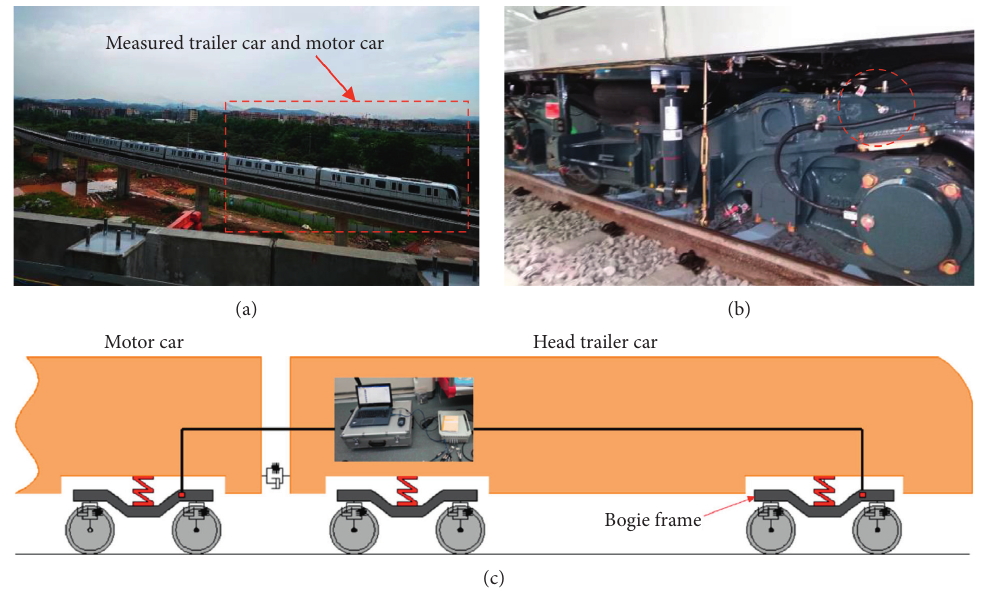
Figure 1: Field test setup. (a) B-type train in field test; (b) measurement points at bogie frames; (c) a schematic of the whole test